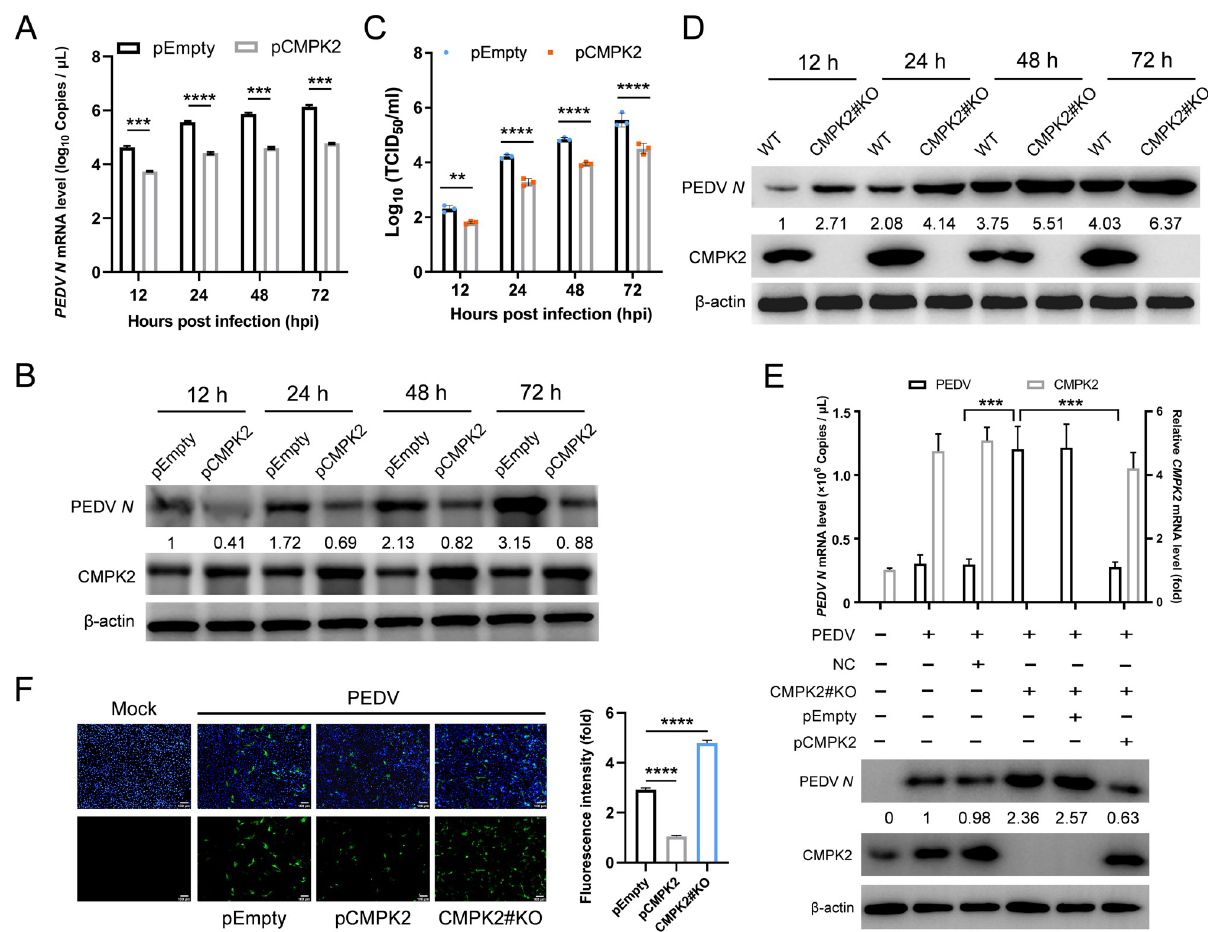
Fig 4. CMPK2 inhibits PEDV replication in IPEC-J2 cells. (A-C) IPEC-J2 cells were transfected with empty vector (pEmpty) and pCMPK2 for 24 h and then infected with PEDV at MOI of 1. The cells and culture supernatants were harvested at indicated time points. Total RNA of the cells was extracted and analyzed by qRT-PCR ( A ), and the cell lysates were analyzed by western blotting ( B ). PEDV titers in the culture supernatants were measured as TCID 50 ( C ). (D) CMPK2 knockout ( CMPK2#KO ) IPEC-J2 cells were constructed and then infected with PEDV as above. The cells were harvested at indicated time points, and the lysates were analyzed by western blotting. (E) CMPK2 knockout IPEC-J2 cells were transfected with pEmpty and pCMPK2 for 24 h and then infected with PEDV as above. Total RNA of the cells was extracted and analyzed by qRT-PCR (upper panel), and the cell lysates were analyzed by western blotting (lower panel). (F) PEDV N antigen was detected in infected cells by indirect IFA. PEDV N (green), DAPI (blue). Scale bars, 100 μ m. Data are means ± SD of triplicate samples; statistical analysis was conducted using one-way ANOVA followed by Dunnett’s multiple comparison test or two-way ANOVA followed by Tukey’s multiple comparison test; only the p -value for the most relevant comparisons are shown for simplicity. The intensities of bands were quantified by ImageJ. �� p < 0.01, ��� p < 0.001, ���� p < 0.0001. Data underlying this figure can be found in S1 Data and S1 Raw Images. CMPK2, cytidine/uridine monophosphate kinase 2; IFA, immunofluorescent assay; MOI, multiplicity of infection; PEDV, porcine epidemic diarrhea virus; qRT-PCR, quantitative real-time PCR.